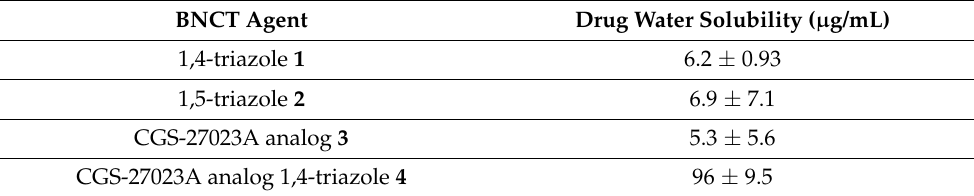
Table 2. Water solubilities determined for carborane-containing MMP ligands 1 – 4